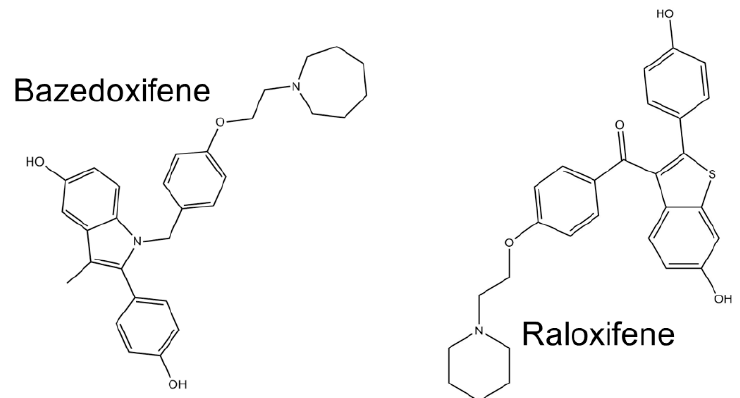
Figure 5. Structure of synthetic oestrogen analogues bazedoxifene and raloxifene.